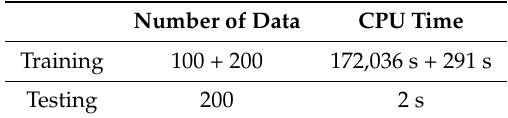
Table 5. CPU time to train and test the proposed surrogate